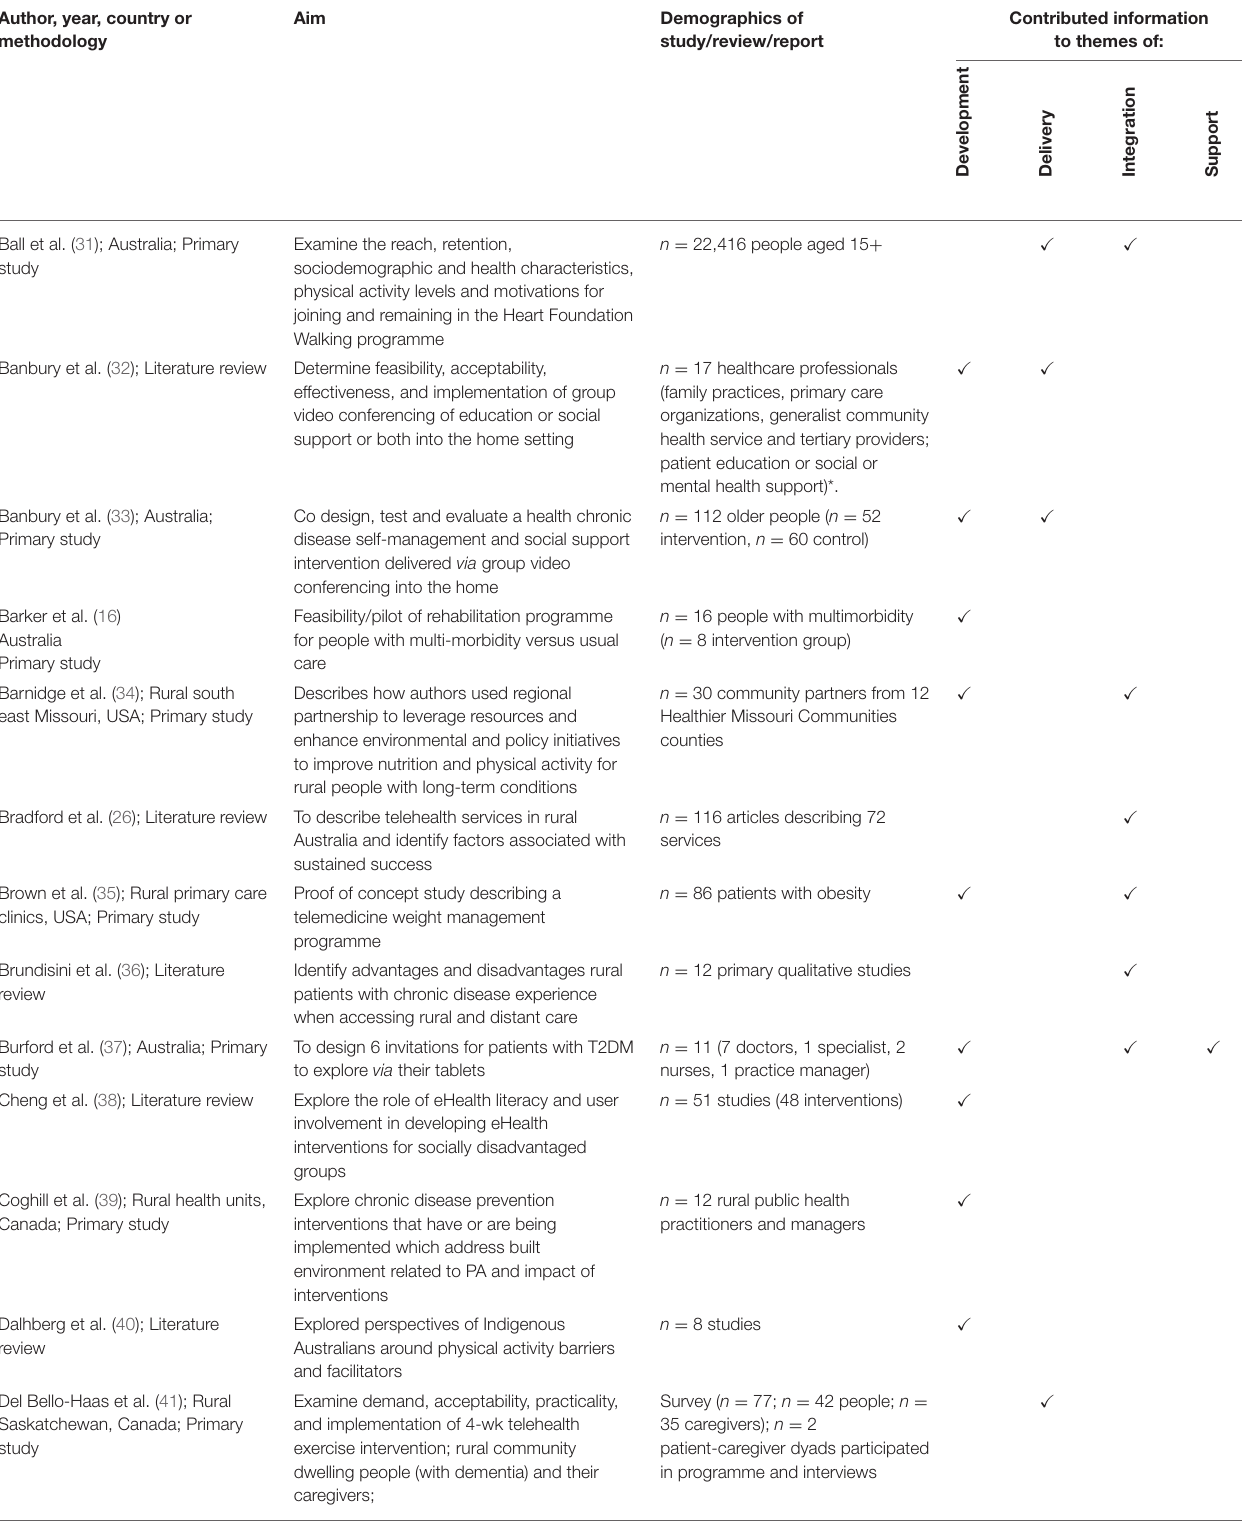
TABLE 3 | Summary of included